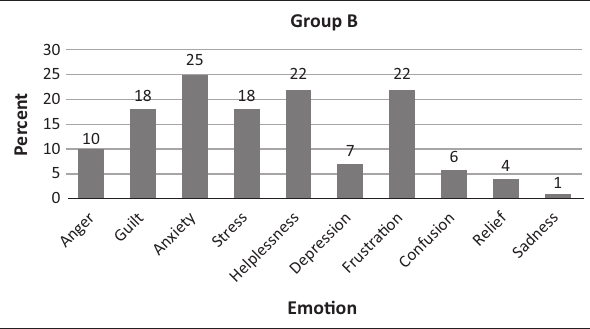
TABLE 4: Mean, standard deviation and p -value comparing emotional perceptions of Group A and Group B. Statement